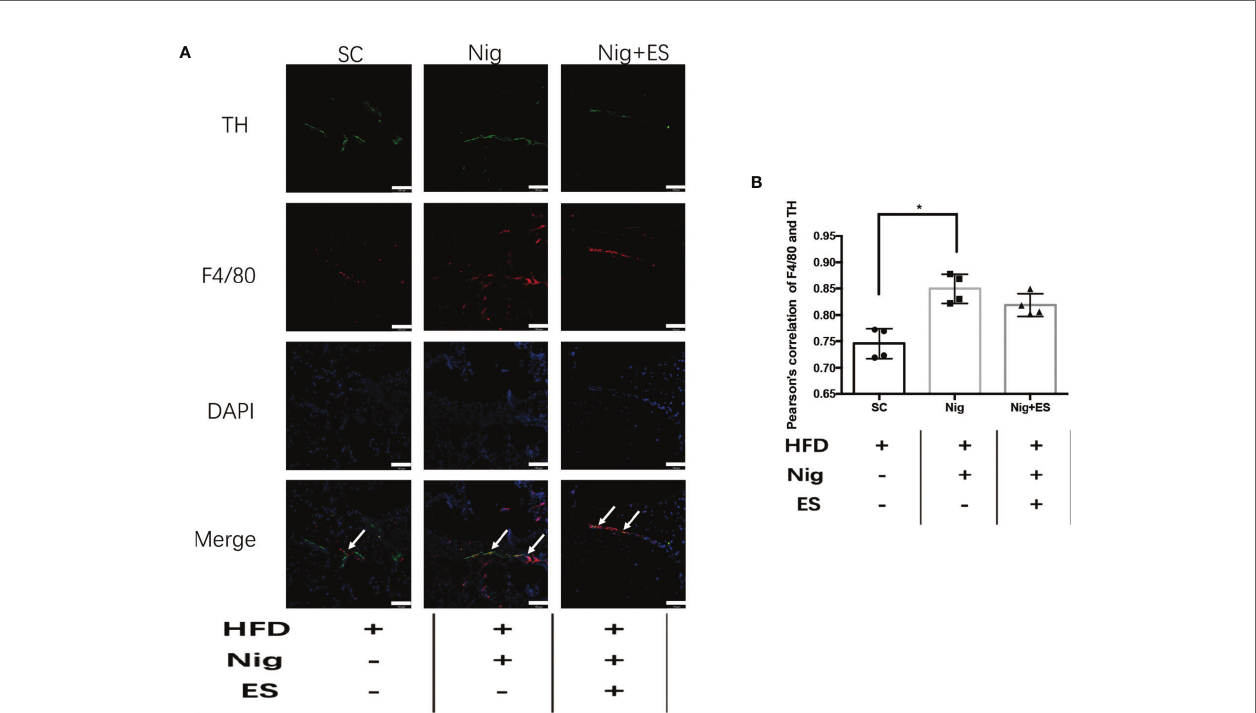
FIGURE 7 | NLRP3 in fl ammasome agonist induced the NAMs in the ES group. (A) Representative images showing TH (green), F4/80 (red), and DAPI (blue) fl uorescence in the SC, Nig, and Nig+ES groups(scale bar, 100 m m). The white arrows in the merged image indicate NAMs. (B) Correlation between F4/80 and TH as indicated by Pearson correlation analysis (n = 4, * P <